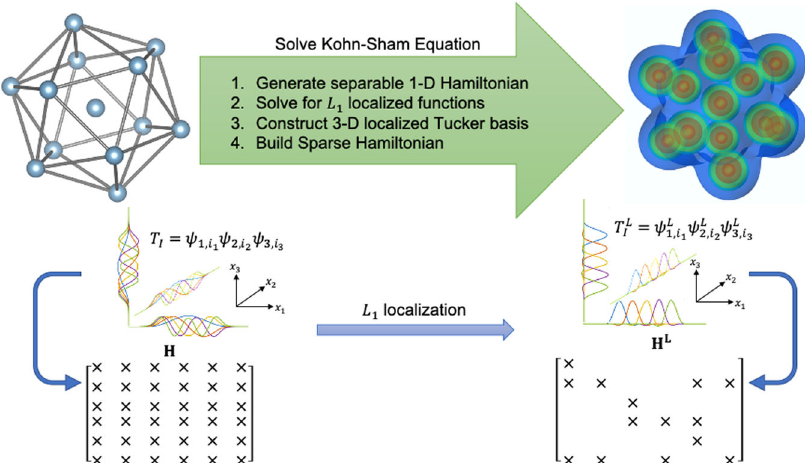
Fig. 1 Overview of the tensor-structured algorithm for Kohn – Sham DFT using L 1 localized functions. The tensor-structured algorithm seeks to construct a systematically convergent reduced-order tensor-structured basis for ef fi ciently solving the Kohn – Sham equations. To this end, an additive separable approximation to the Kohn – Sham Hamiltonian is constructed, whose eigenbasis presents a suitable reduced-order ψ ψ = ( i – Sham Hamiltonian in this basis is dense basis, given by T I ¼ ψ 1 ; i 1 , i 2 , i 3 ). However, the discrete Kohn 2 ; i 2 3 ; i 3 , where I is a composite index I 1 , k = 1, 2, 3 (lower-left). The L 1 localization is applied to alleviate this bottleneck, where due to the global nature of the 1-D functions ψ k ; i k localized tensor-structured basis functions are constructed such that the subspace spanned by this localized basis is a close approximation to , the 3-D localized basis functions are given by the eigensubspace of the separable Hamiltonian. Denoting the localized 1-D functions by ψ L k ; i k ψ L ψ L ψ L T L . The 3-D localized basis functions, being compactly supported, yields a sparse Hamiltonian (lower-right). The resulting I ¼ 1 ; i 1 2 ; i 2 3 ; i 3 sparse Hamiltonian, in conjunction with the slow growth of the Tucker rank with system-size to accurately represent the electronic